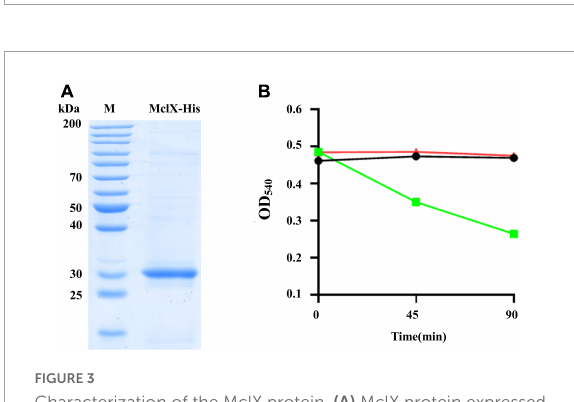
FIGURE2 mclX transcription activity. (A) Gene map of the RS12915 - RS12925 ; (B) mclX transcription activities in the wild-type strain HD73, HD ( (cid:49) gerE ), and HD ( (cid:49) sigK ) (HD73-P mclX , circles; HD (cid:49) gerE -P mclX , squares; HD (cid:49) sigK -P mclX , triangles). Tn means n hours after the exponential phase ended. Error bars show standard error of the mean.